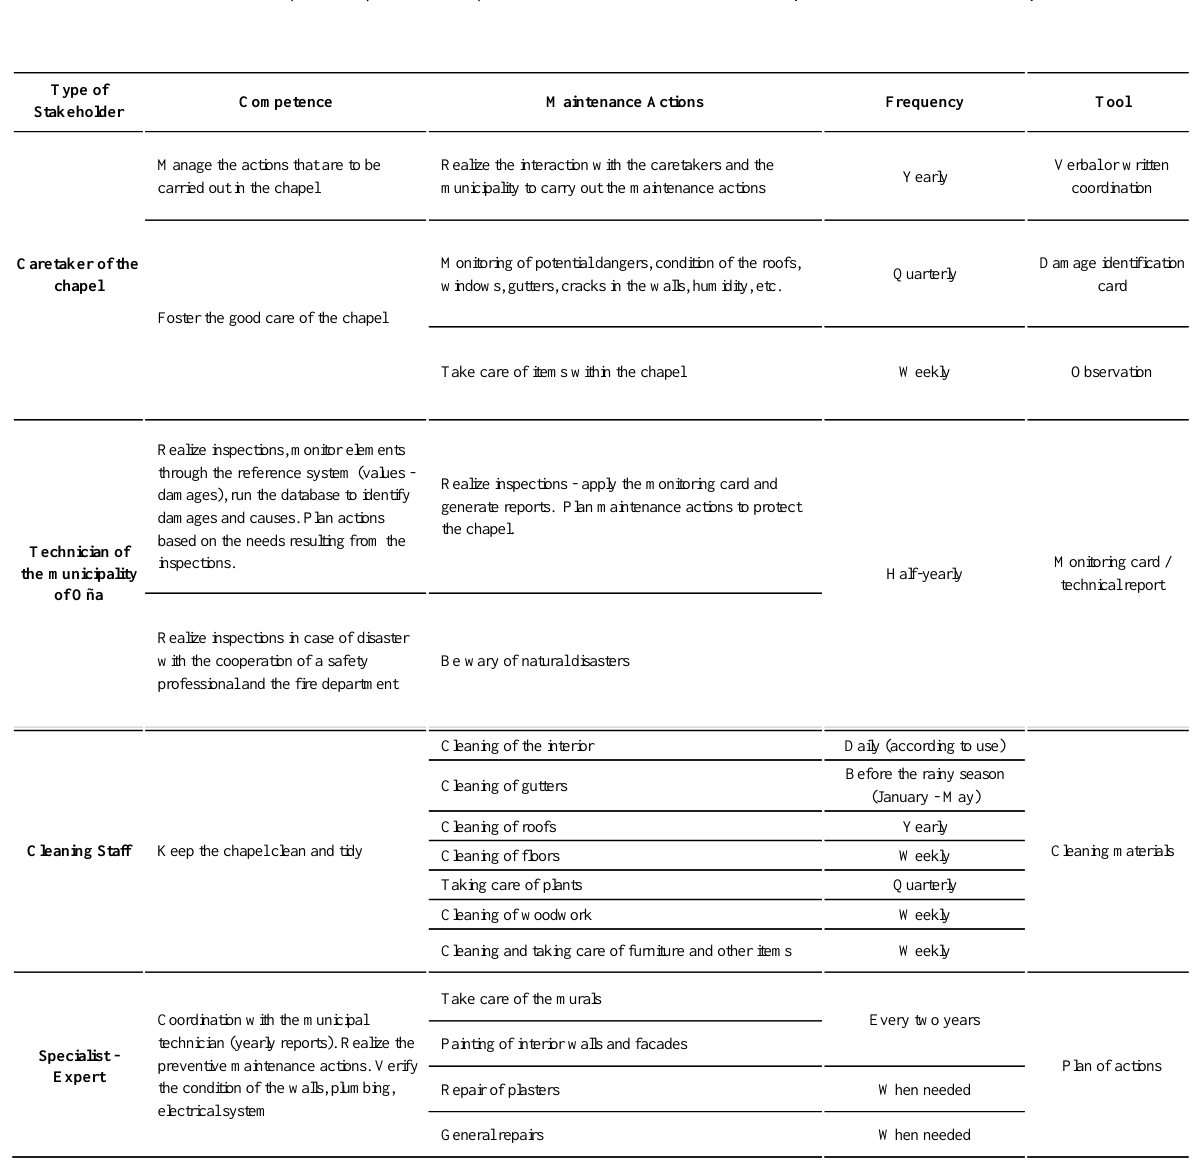
Table 1. Identification of stakeholders and the activities to be carried out for the monitoring of the chapel. Source: Barsallo,